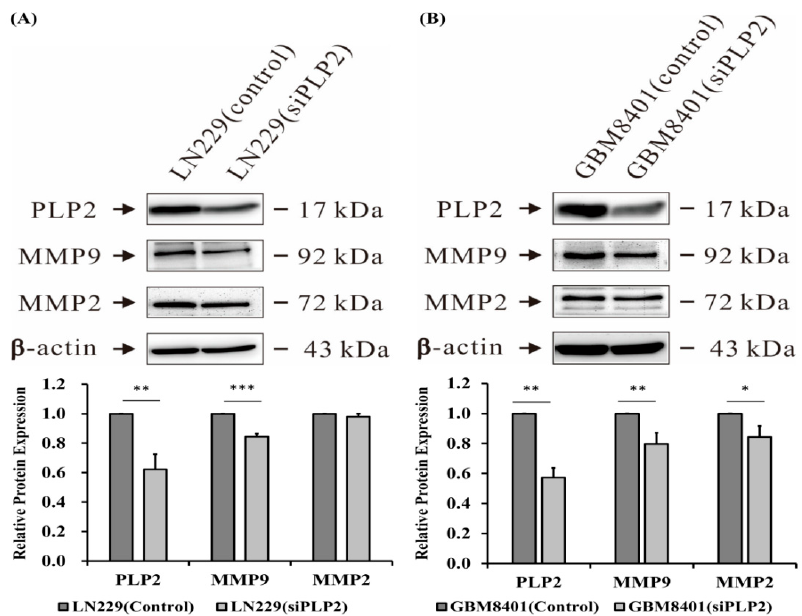
Figure 8. The detection of tumor cells and matrix interaction analyzed by metalloproteinase 2 (MMP2) and metalloproteinase 9 (MMP9) expression between the groups of siPLP2 and NC and ( B ) GBM8401 glioma cells. Compared to NC transfection, both of above glioma cells with transfected ( A ) LN229 and ( B ) GBM8401 glioma cells. Compared to NC transfection, both of above